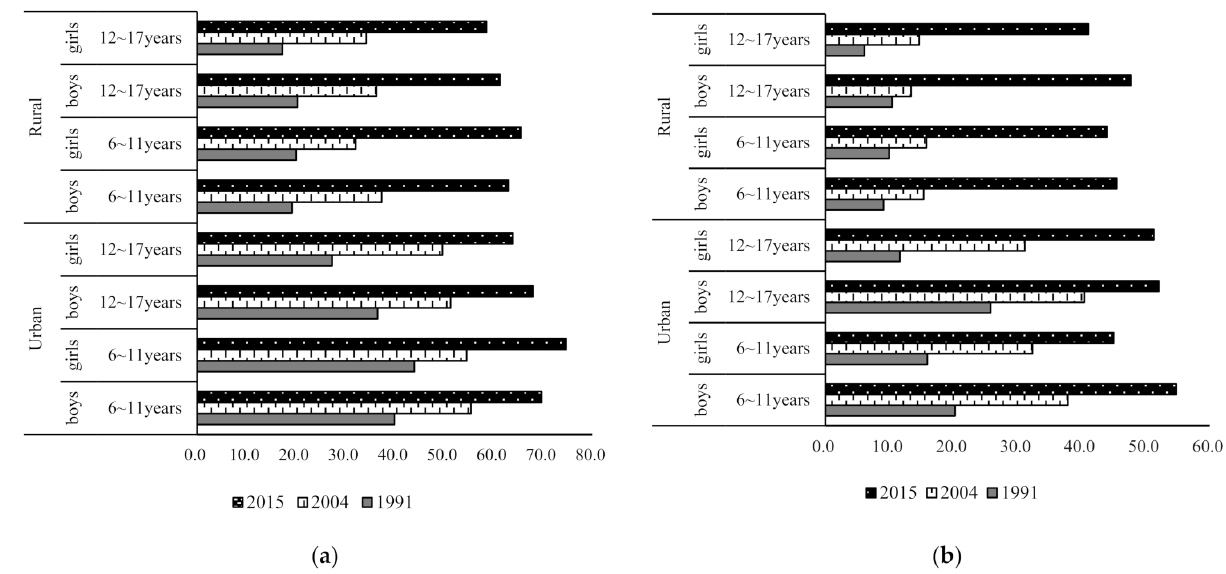
Figure 1. Trends of the proportion of children aged 6 to 17 years with more than 30% of energy from fat and less than 50% of energy from carbohydrates. ( a ) The proportion of children with more than 30% of energy from fat; ( b ) the proportion of children with less than 50% of energy from